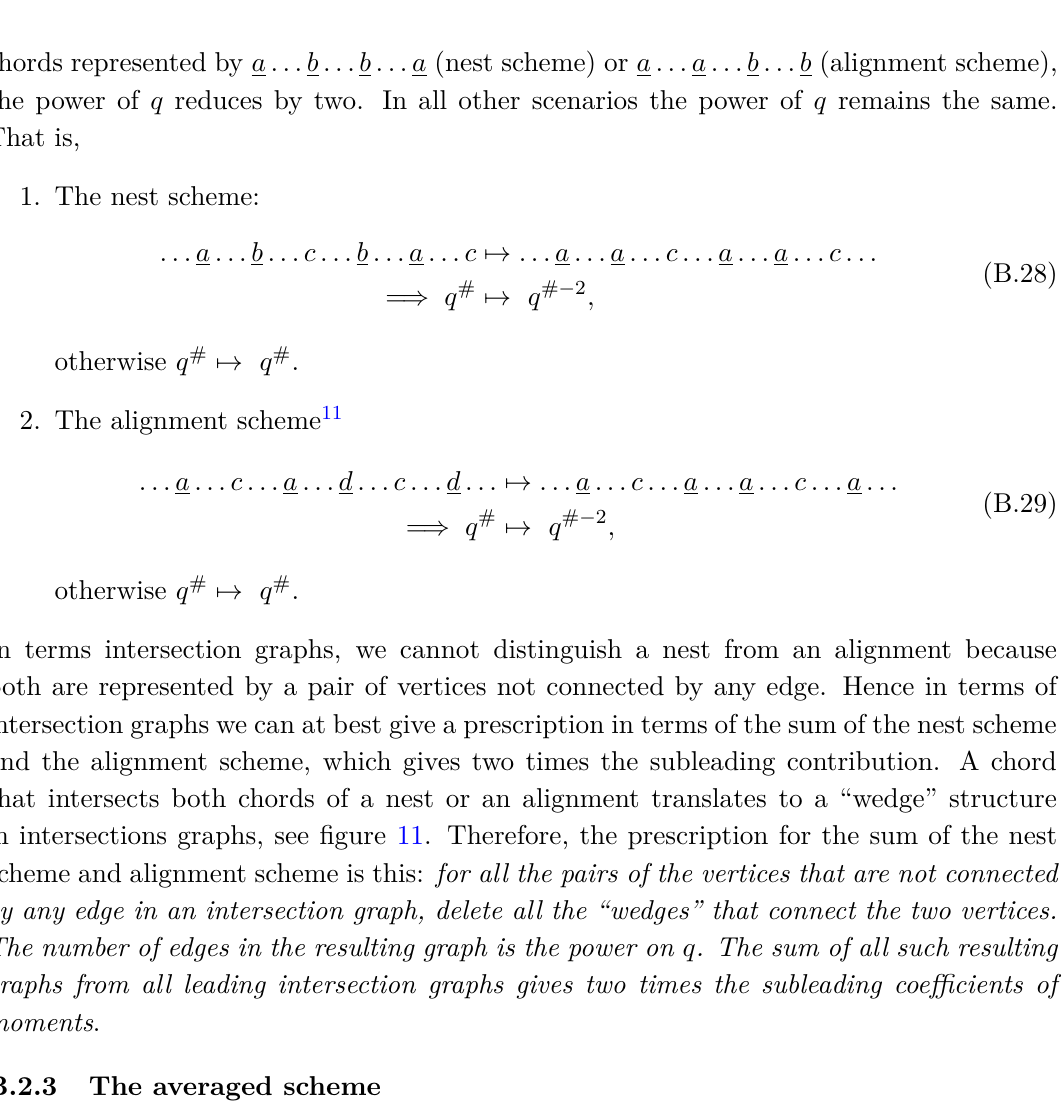
Figure 11 . The two left figures show a chord c intersecting both chords in a nest structure and in an alignment structure. Note only the underlined letters represent the nest or alignment structures. The right figure shows the intersection graph of such